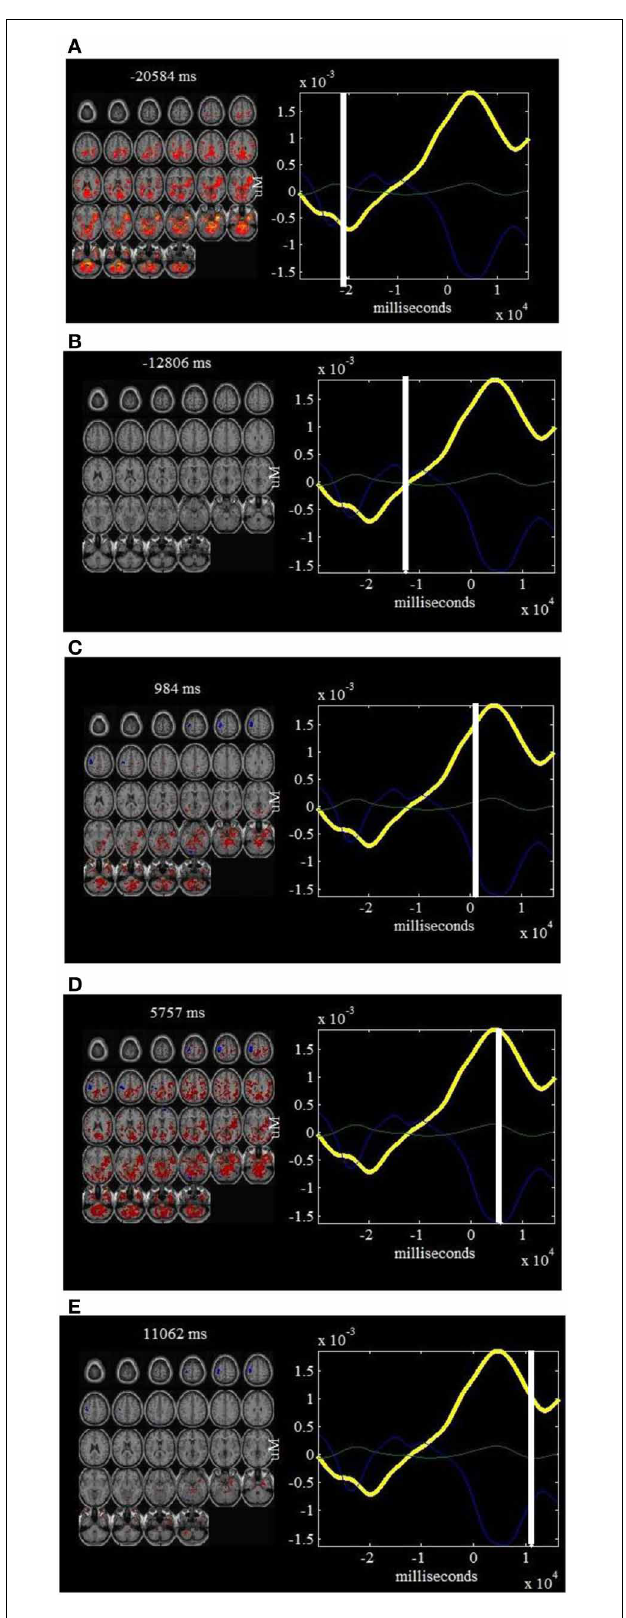
FIGURE 5 | (cid:2) HbO 2 components and fMRI “snapshots”: on the left of each window is shown a linear combination of the fMRI maps that are well-correlated with physiology and body movement noise (composite ICs 1 and 3), weighted by the (cid:2) HbO 2 part of the components at a specific point in time. On the right of each window is shown the estimated (cid:2) HbO 2 components that are correlated physiology and body movement noise. The time courses for IC1 (in blue) and IC3 (in green) are also plotted on the right of each window. Such a display provides a dynamic way to visualize how the noise affects the brain activity at different time points: − 20584ms (A) , − 12806ms (B) , 984ms (C) , 5757ms (D) and 11062ms (E)